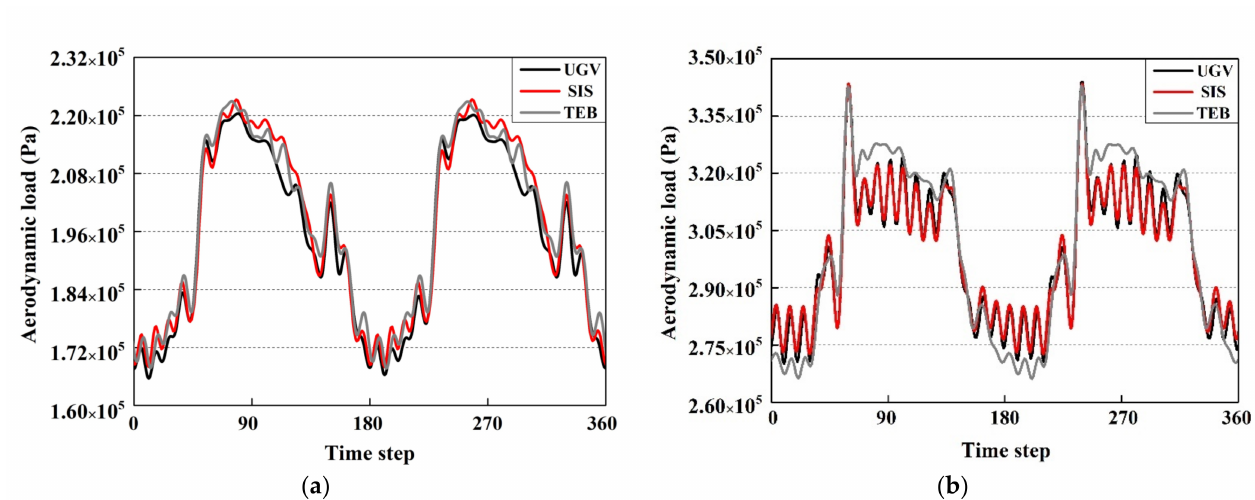
Figure 12. The aerodynamic load comparison of the time history oscillations ( a ) P3 and S3, and ( b ) P10 and S10 in different radial inlet models.